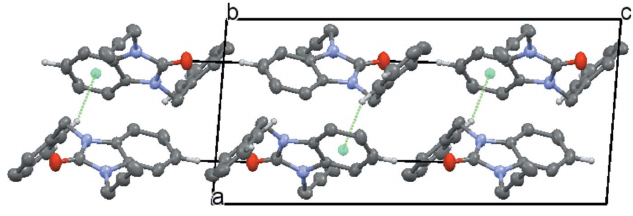
Figure 3 Elevation view of two layers seen along the b -axis direction. C—H (cid:3)(cid:3)(cid:3) O hydrogen bonds are shown by black dashed lines while C—H (cid:3)(cid:3)(cid:3) (cid:2) (ring) interactions are shown by green dashed lines.